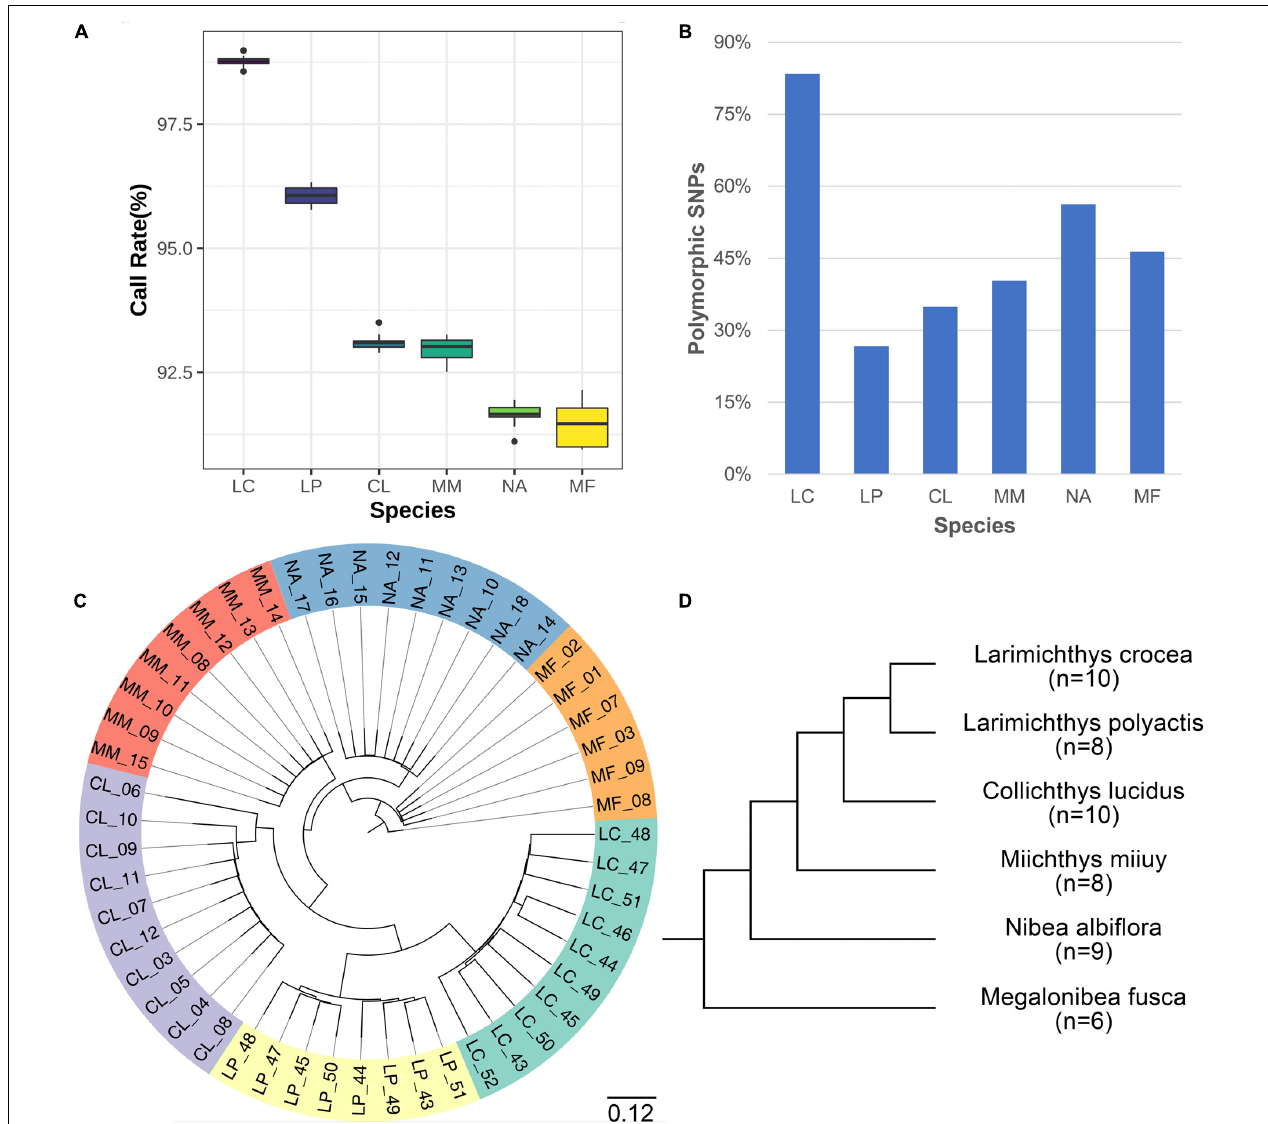
FIGURE 5 | Evaluation of single-nucleotide polymorphism (SNP) array in five species in Sciaenidae that are closely related to large yellow croaker. (A) Call rate of SNPs in Sciaenidae species. (B) Percent of polymorphic SNPs in Sciaenidae species. (C) Phylogenetic tree of the species in Sciaenidae generated by using the genotyping data. (D) Evolutionary distance of the species in Sciaenidae by phylogenetic analysis (Modified from Jiang et al., 2014). LC, Larimichthys crocea ; LP, Larimichthys polyactis ; CL, Collichthys lucidus ; MM, Miichthys miiuy ; NA, Nibea albiflora ; MF, Megalonibea fusca .